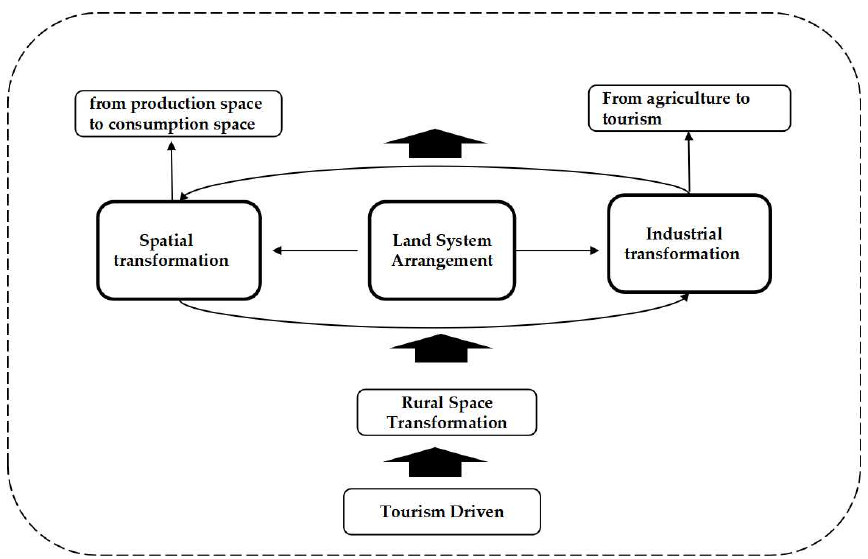
Figure 6. Analysis Framework of Tourism driven and Rural space transformation. (Source: drawn by the authors).